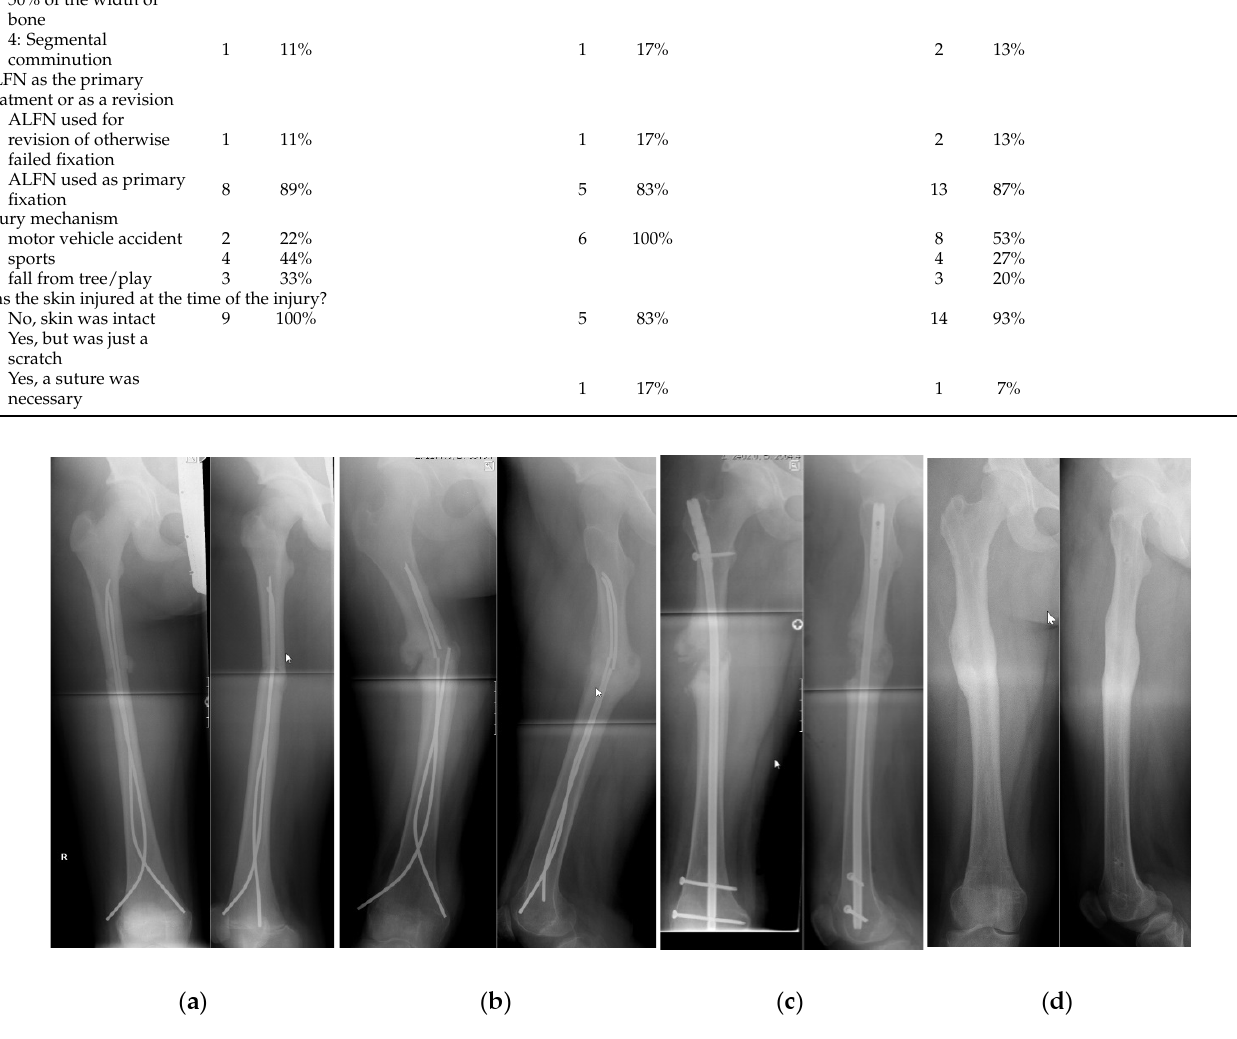
Figure 2. ( a ) 1 week after ESIN for a femoral fracture. Please note the narrow intramedullary canal, prohibiting the use of nails with a thicker diameter. Although currently we would advance the elastic intramedullary nail further, we do not consider this a reason for the subsequent failure of this fixation. ( b ) Same patient as in Figure 2a, now 9 months after ESIN. There is failure of the elastic nail due to non-union, resulting in a malposition. ( c ) Now 1 week after revision with an ALFN. Note the correction of the malposition. ( d ) After removal of the ALFN: radiographic bony union in correct position.